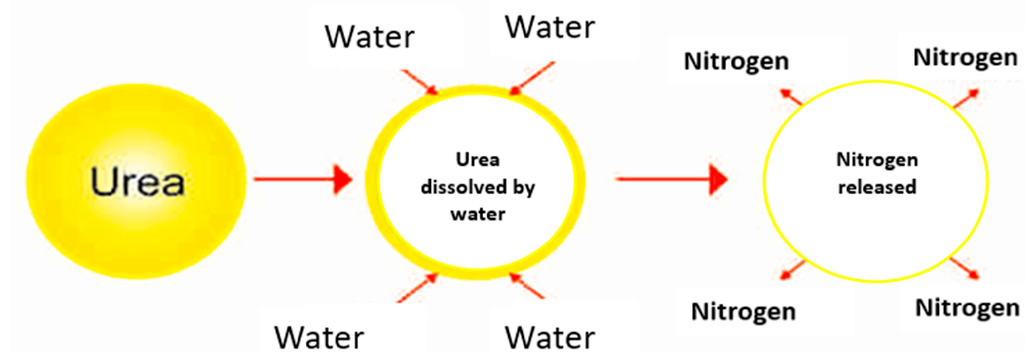
Figure 5. Di ff usion mechanism of nitrogen released from coated urea. Figure 5. Diffusion mechanism of nitrogen released from coated urea.